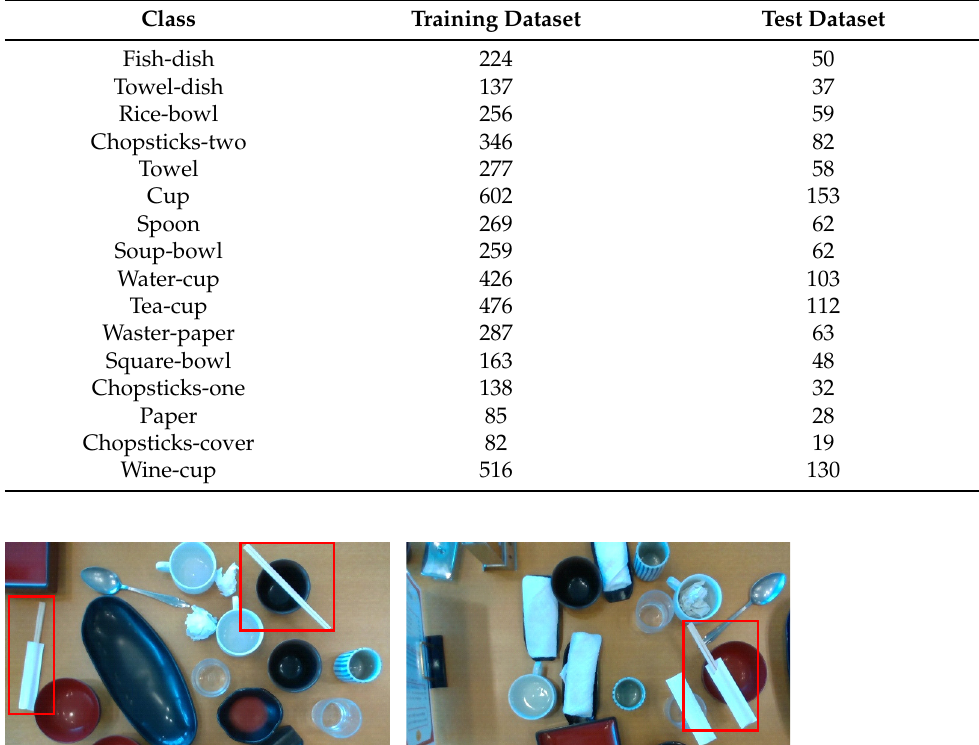
Table 8. Number of each kind of dish in the dataset